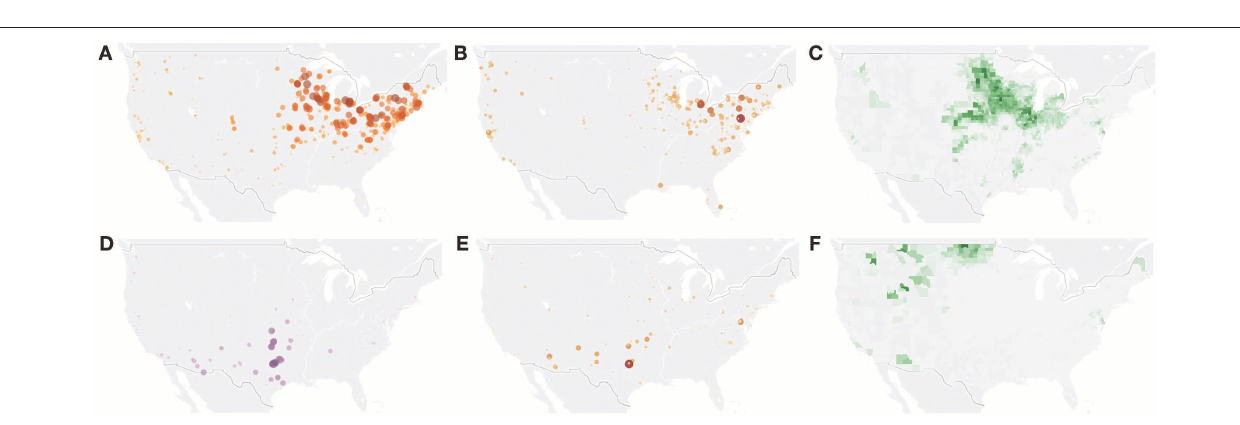
Frontiers in Ecology and Evolution |